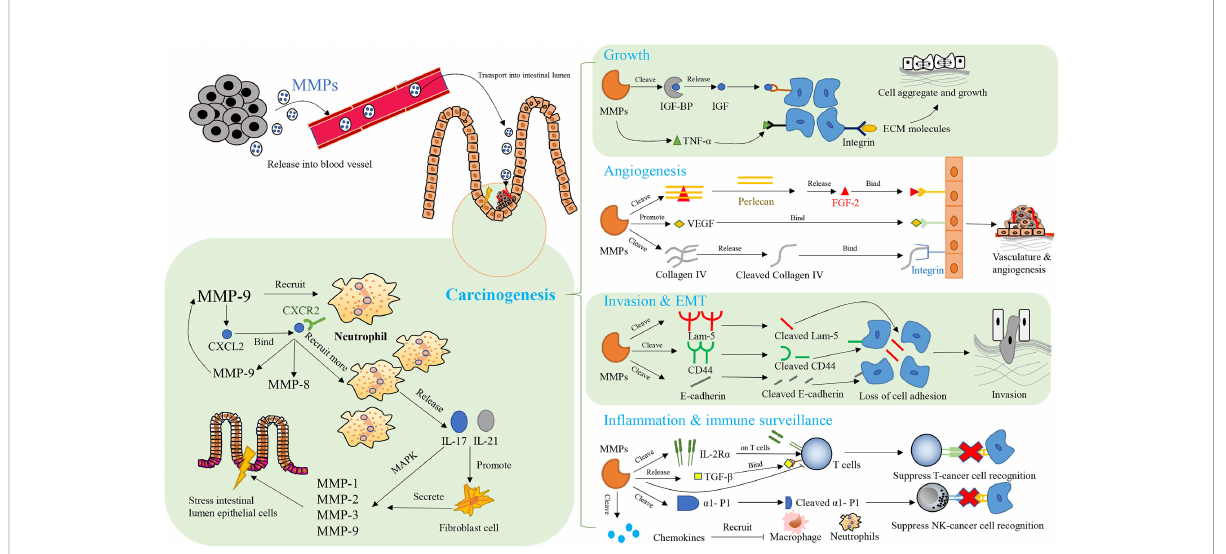
FIGURE 4 The network of MMPs and therapeutic targets in colitis-associated cancers (CAC). Key aspects of carcinogenesis are mediated by MMPs, including cell growth, angiogenesis, invasion, epithelial-mesenchymal transition (EMT), in fl ammation, and immune surveillance in immunomodulatory manner. CXCL2: CXC-chemokine ligand 2; CXCR 2: CXC chemokine receptor 2; MAPK, mitogen-activated protein kinases; FGF-2, fi broblast growth factor 2; IGF, insulin-like growth factors; IGF-BP, insulin-like growth factors binding protein; TNF- b , tumor necrosis factor- b ; TNF- a , tumor necrosis factor- a ; ECM, extracellular matrix; Lam-5, laminin-5; CD44, cluster of differentiation-44; VEGF, vascular endothelial-derived growth factor; a 1-P1, alpha 1- proteinase inhibitor;IL-17, interleukin-17; IL-21, interleukin-21; IL-2R a , interleukin-2 receptor